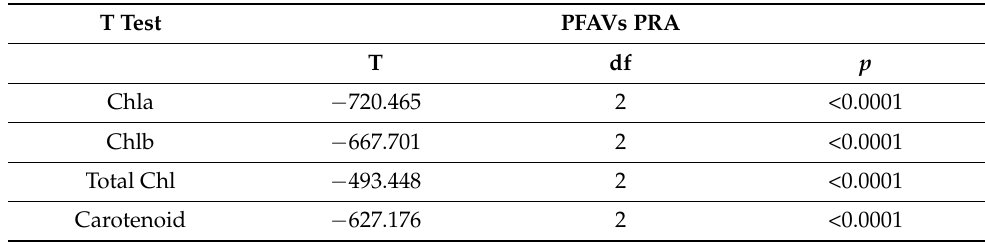
Table 10. T test depicting the efficacy of ANE on pigment accumulation in pot foliar application (PFA) and pot root application (PRA)